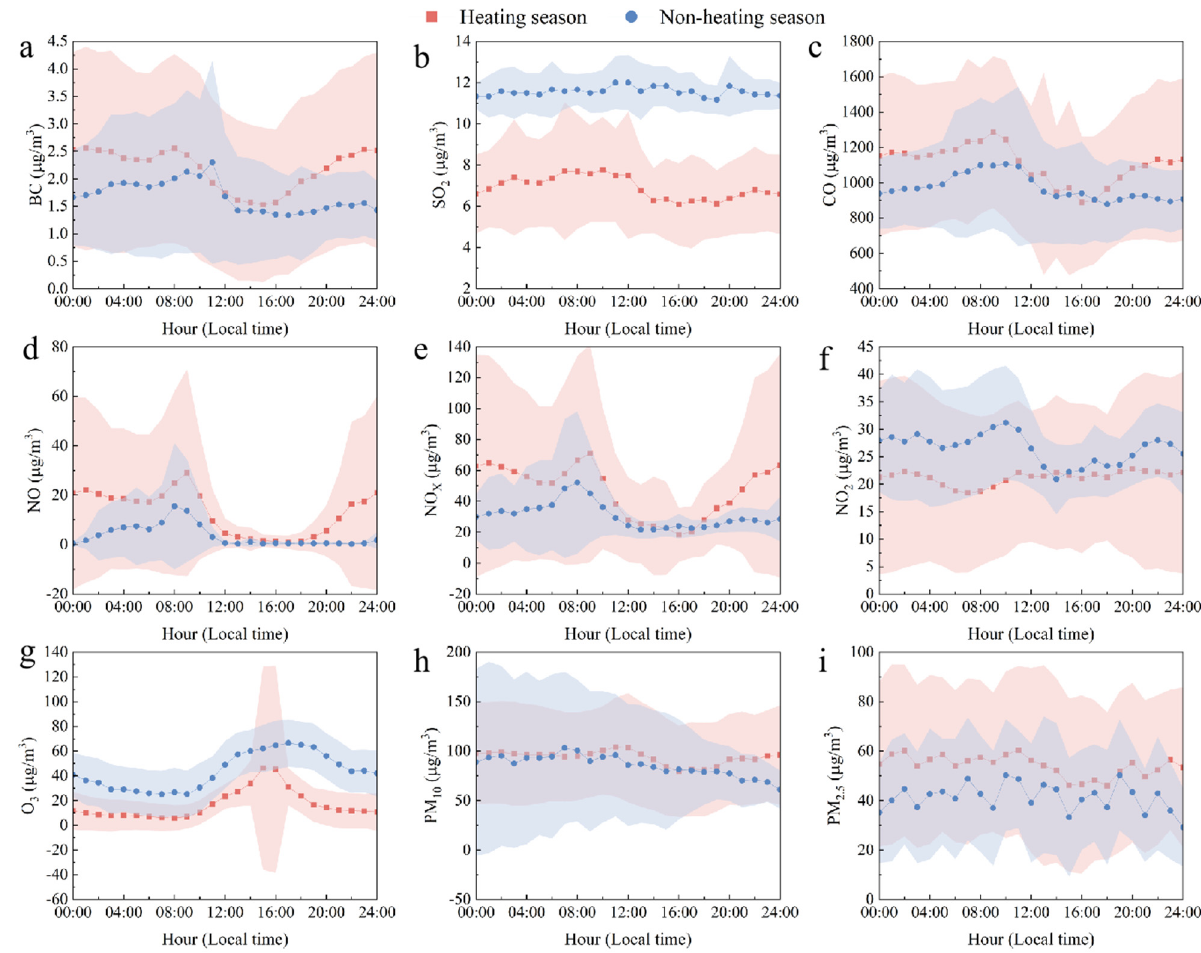
Figure 8. Daily changes in the hourly mean concentrations of ( b ) SO 2 , ( c ) CO, ( d ) NO, ( e ) NO X , ( f ) NO 2 , ( g ) O 3 , ( h ) PM 10 , ( i ) PM 2.5 , and ( a ) BC during the heating and non-heating seasons.